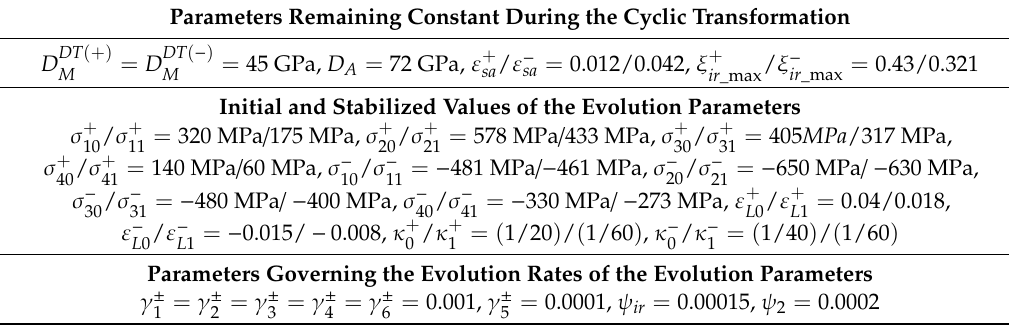
Table 2. Material parameters used in the proposed model for pseudo-elastic SMAs at room temperature. (NiTi alloys - Ni, 50.2